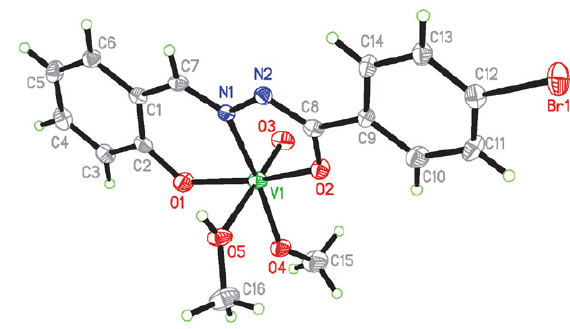
Figure 2. The molecular packing diagram of H 2 L, viewed down the a axis. Hydrogen bonds are shown as dashed lines.